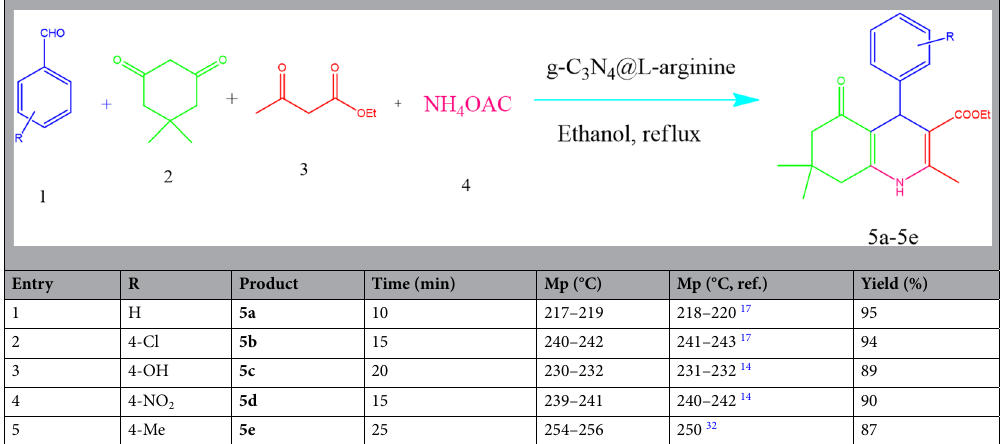
Table 2. Synthesis of 1,4-dihydropyridine derivatives using g-C 3 N 4 @l-arginine nanocatalyst. Reaction conditions: benzaldehyde (1 mmol), ethyl acetoacetate (1 mmol), dimedone (1 mmol), and ammonium